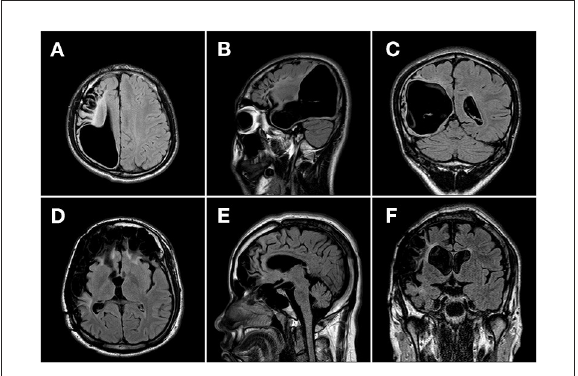
FIGURE2 Representative MR images of patients with pharmacoresistant epilepsy secondary to encephalomalacia. Representative MR images (T2-weighted fluid-attenuated inversion recovery image) of two patients with pharmacoresistant epilepsy secondary to encephalomalacia in the axial (A, D) , sagittal (B, E) , and coronal (C, F) planes. (A–C) A 17-year-old boy with unilateral encephalomalacia on MRI due to intracranial hematoma. The encephalomalacia was observed in the right frontal, parietal, and temporal lobes. The patient got a reduction of 80% in seizure frequency after 1 year following the VNS therapy. (D–F) A 24-year-old man with bilateral encephalomalacia on MRI due to head trauma. The encephalomalacia was observed in the right temporal and parietal lobes, as well as in bilateral frontal lobes. The patient got no reduction in seizure frequency during a 3-year follow-up after the VNS